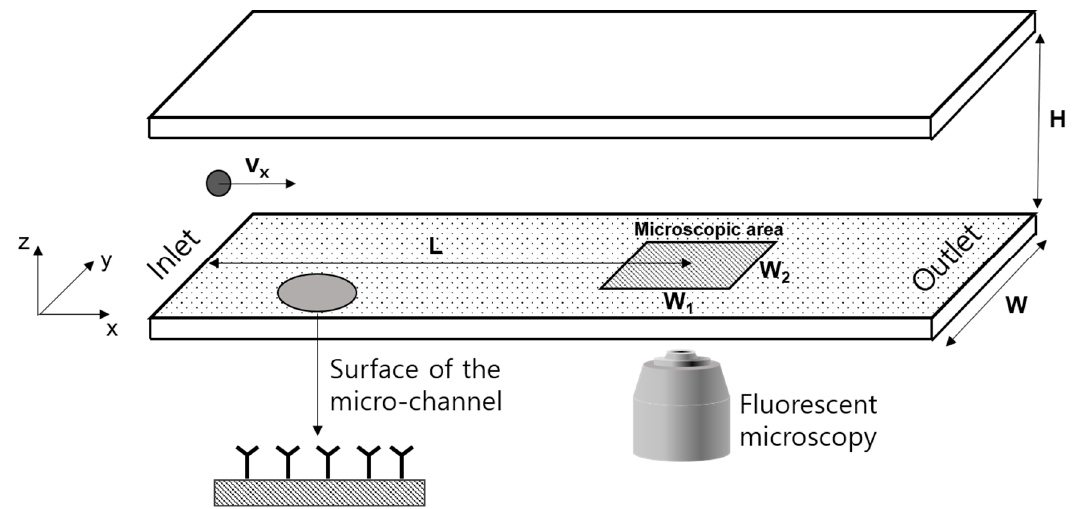
Figure 2. Configuration of the micro-fluidic biosensor for analyte-receptor binding experiments.